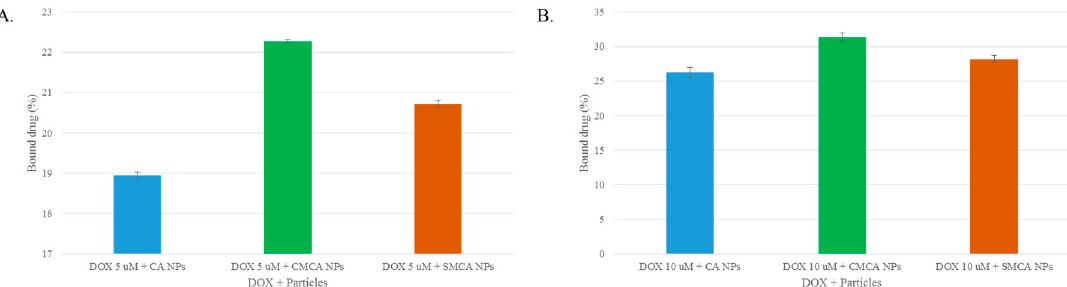
Figure 4. Fluorescence intensity analysis of free DOX and DOX-loaded CA and CMCA NPs. ( A ) drug binding efficiency (%) of CA, CMCA and SMCA NPs for 5 µM DOX; ( B ) drug binding efficiency (%) of CA, CMCA and SMCA NPs for 10 µM DOX.